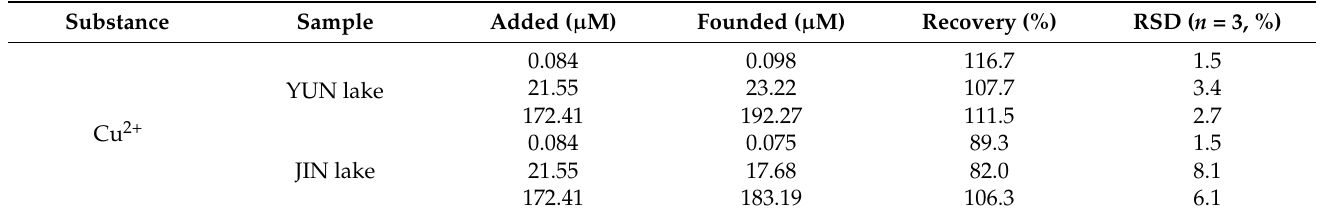
Table 4. Determination of Cu 2+ , ST, and glucose in lake water, milk, and fruit samples,